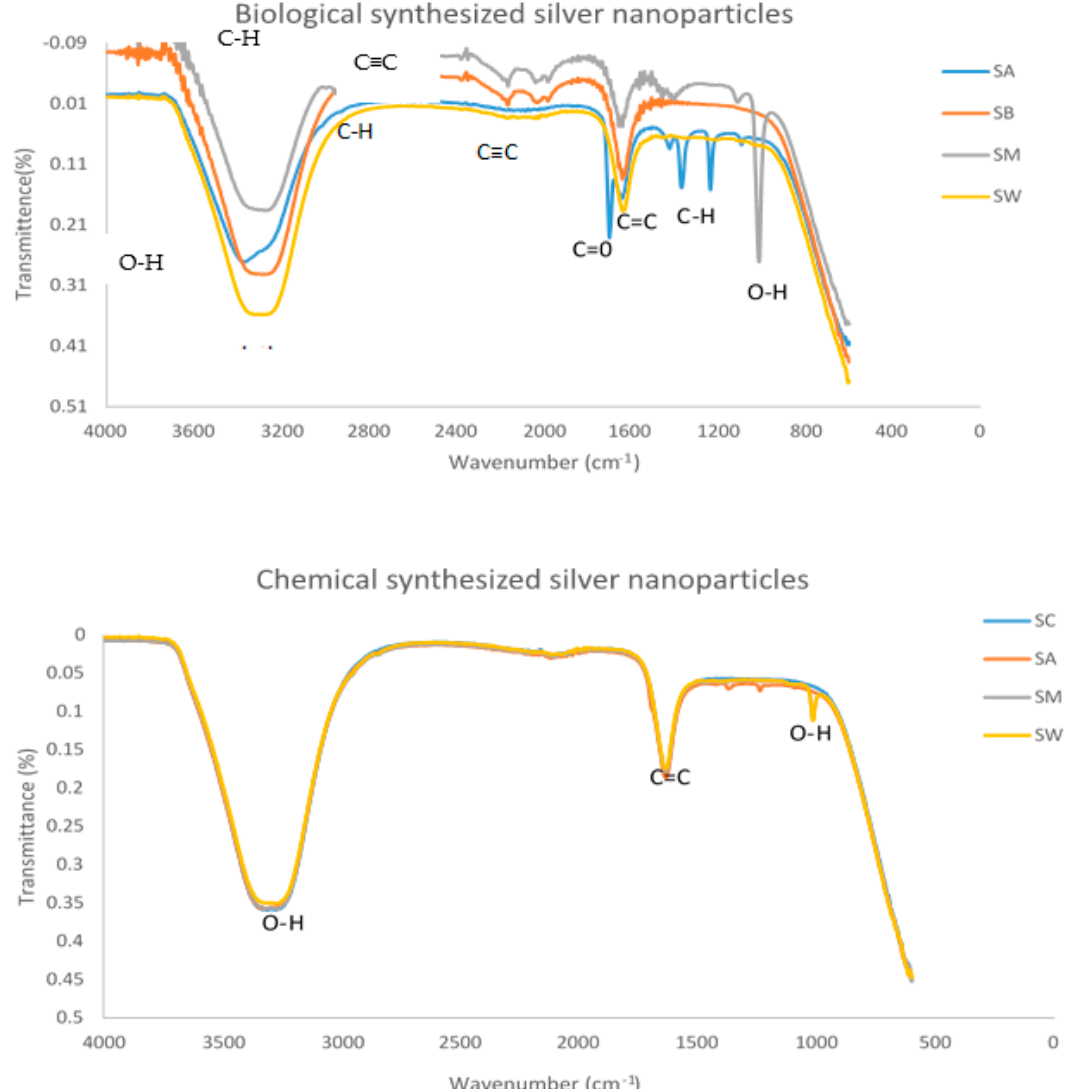
Figure 4. FTIR spectrum of plant extracts conjugated with silver nanoparticles. SB (Biologically synthesized silver nanoparticles), SA (Silver nanoparticles and acetone extract), SM (Silver nanoparticles and methanol extract), SW (Silver nanoparticles and water extract) and SC (Chemically synthesized silver nanoparticles).